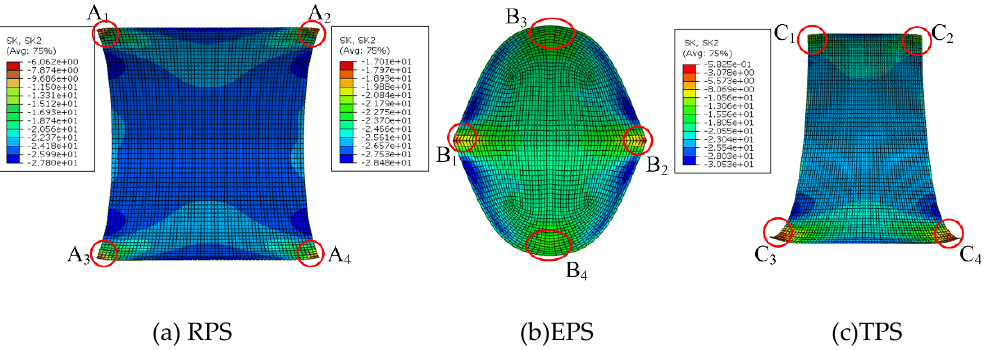
Figure 10. The curvature distribution of k x 2 of anti-symmetric cylindrical shells with different planform shapes (vertical view).